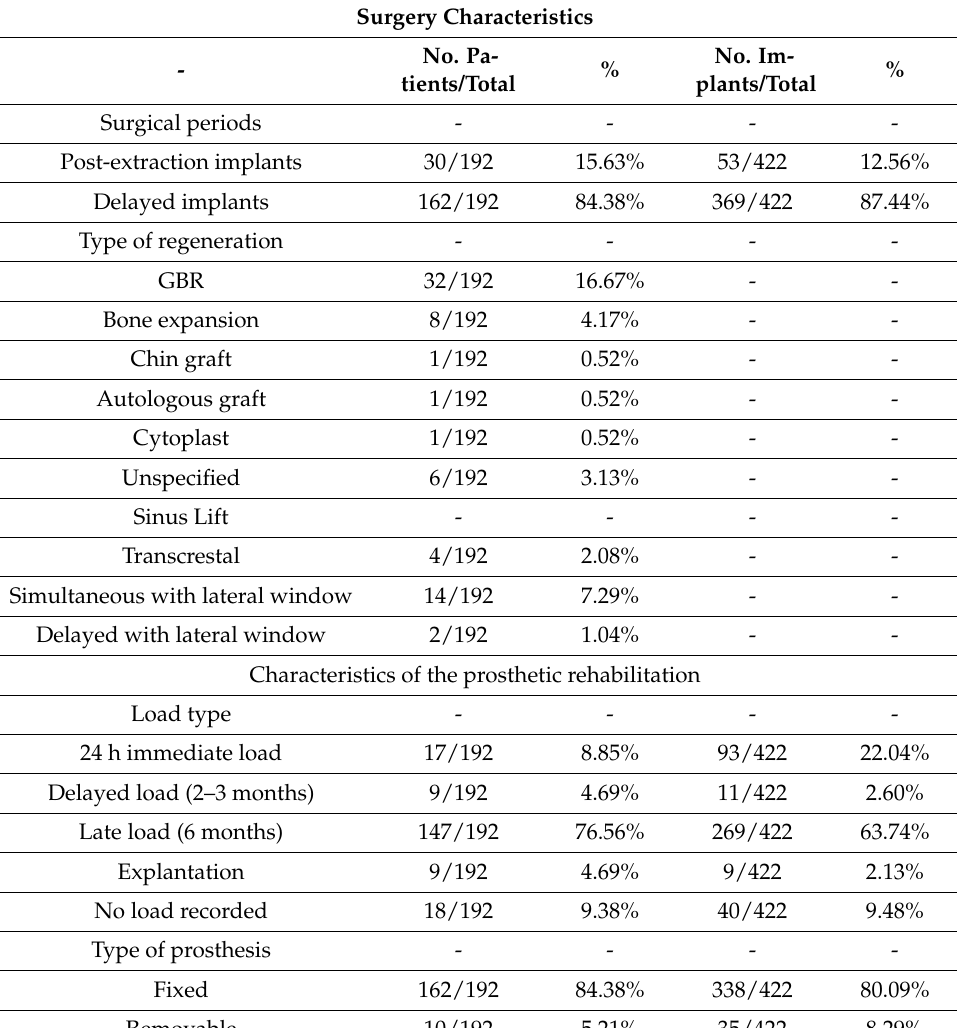
Table 4. Characteristics of the surgery and prosthetic rehabilitation. GBR: guided bone regeneration.